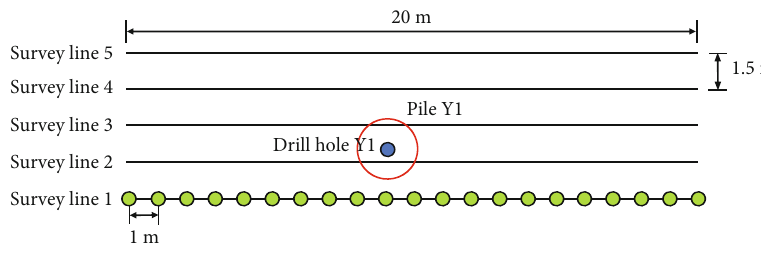
Figure 4: Monitoring